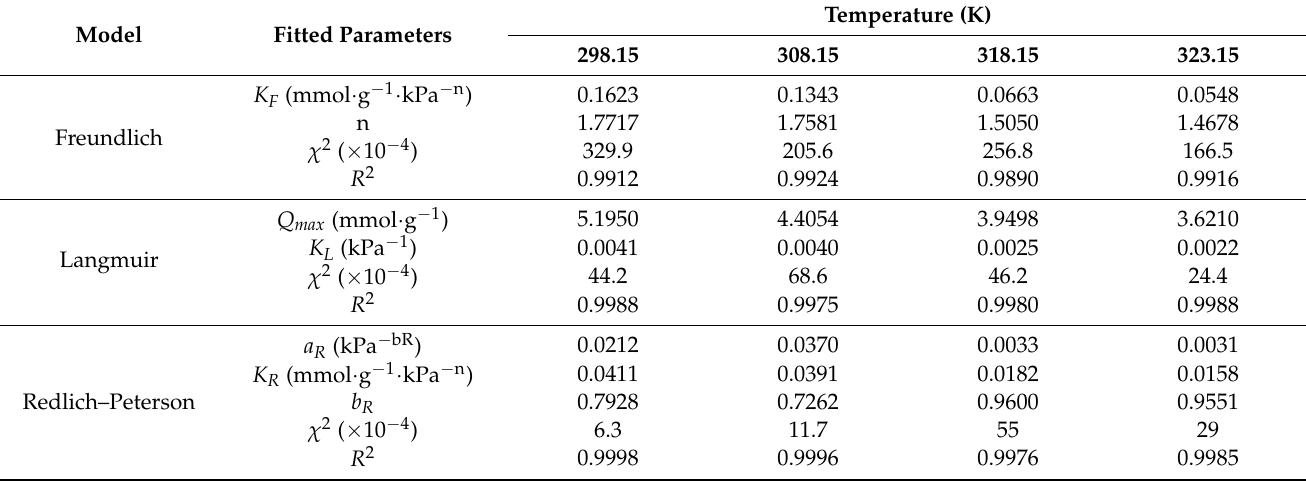
Table 2. Fitting parameters of models for CO 2 adsorption by the GO(0.25)/MR-500 at different adsorption temperatures. Model Fitted